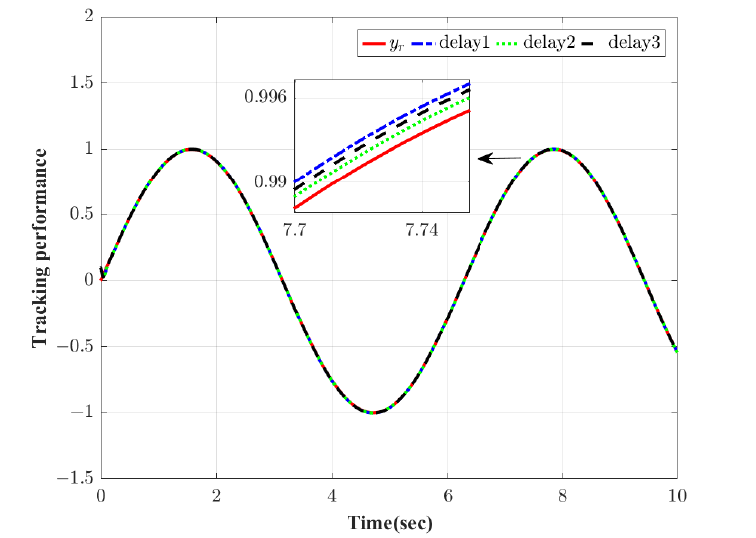
Figure 7. Tracking